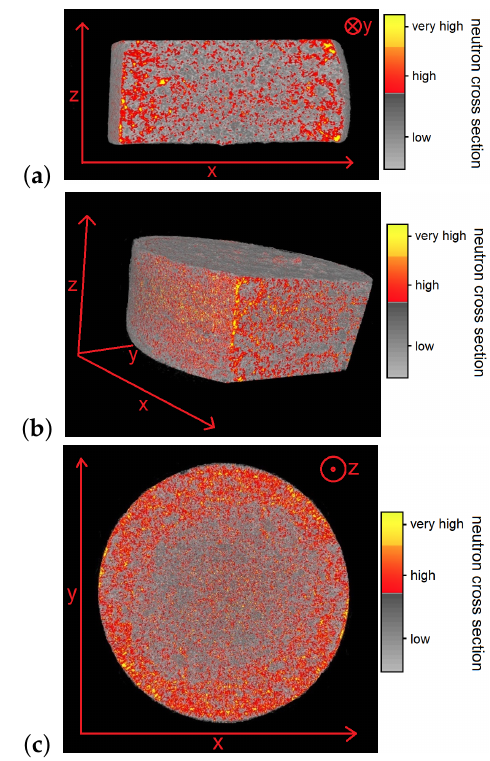
Figure 7. This figure shows the three-dimensional density distribution of a cylindrical CEM I (G/Z = 6/1) sample, which contains only residual water, created by neutron tomography. Different macroscopic neutron cross sections of the material are differently coloured, where the highest cross sections are illustrated in yellow, high cross sections in red and low values in greyscale. The ( a ) A Vertical section through the sample; a Gaussian filter was used to reduce the noise. ( b ) A vertical section through the sample in a different viewing angle. ( c ) A horizontal section through the